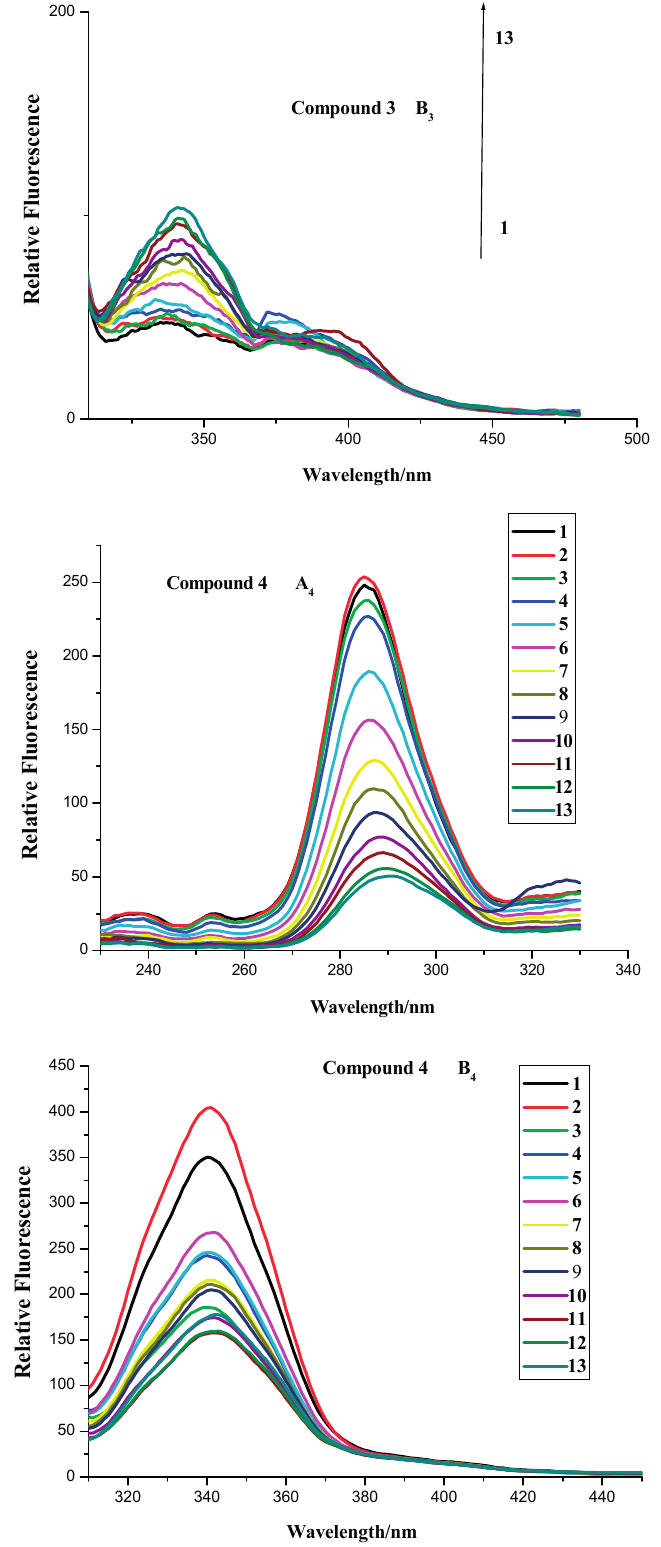
Figure 9. Synchronous fluorescence spectra of compounds-BSA system. (A: Δλ = 15 nm, B: Δλ = 60 nm). The concentrations of BSA and compounds were the same as those in Figure